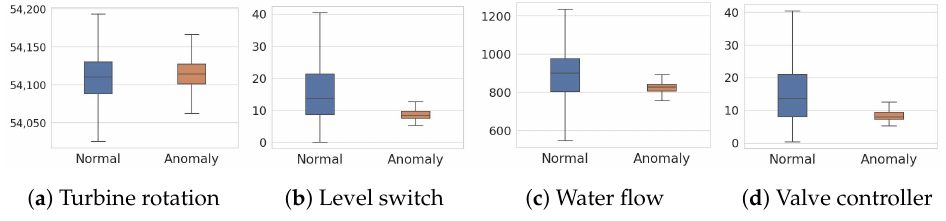
Figure 5. Box plots of normal and anomaly features in the HAI